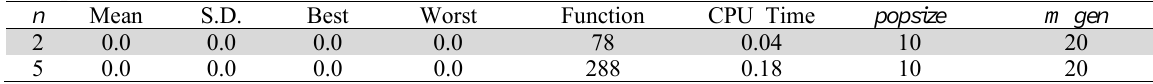
Computational Results of Problem -8